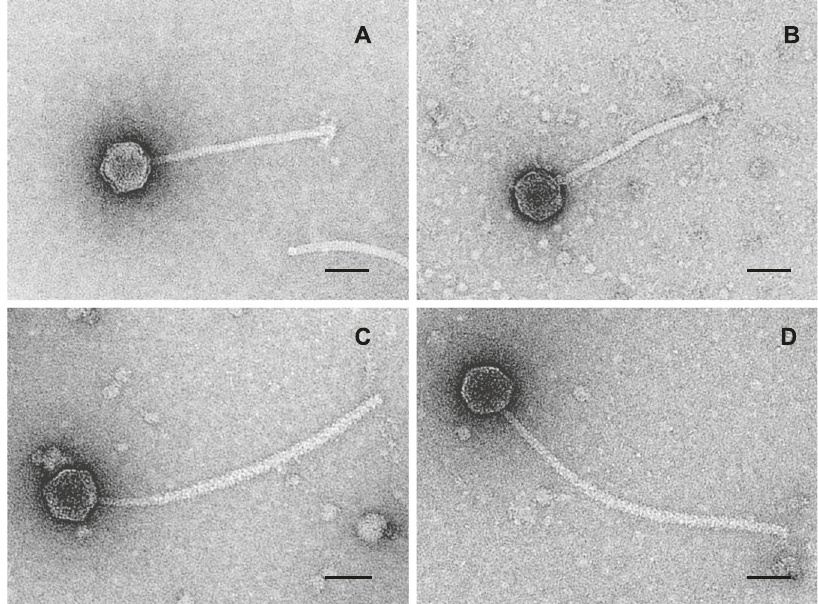
Fig. 2 Transmission electron micrographs of temperate phages isolated in this study. The bar indicates 50 nm. A NrS-2 from Nitratiruptor sp. YY08-10, ( B ) NrS-3 from Nitratiruptor sp. YY08-14, ( C ) NrS-4 from Nitratiruptor sp. YY08-13, and ( D ) NrS-5 from Nitratiruptor sp. YY08-26.